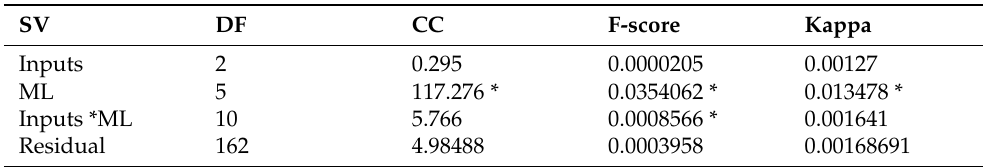
Table 3. Summary of the analysis of variance for the variables percent correct classification (CC), F-score, and Kappa coefficient.